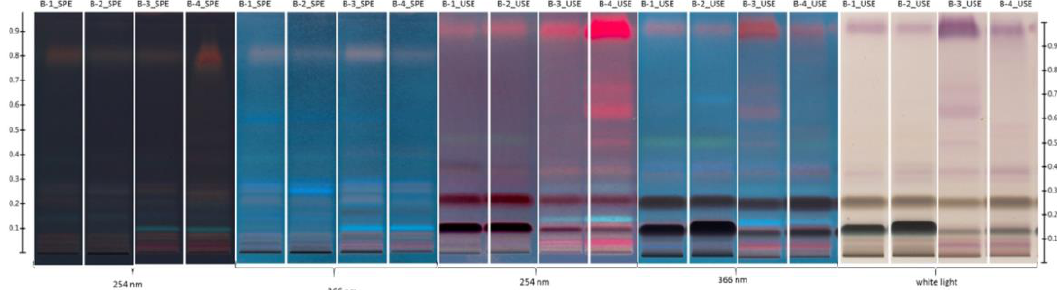
Figure 1. Represented HPTLC fingerprint of buckwheat honey after derivatisation (UAE—ultrasound solvent extraction, SPE—solid phase extraction visualised under white light, 254 nm and 366 nm; B1–B2 cv. Kora; B3–B4 cv. Panda; in Panda cv. we observed additional band on the chromatograms and, moreover, concentration of compound with Rf = 0.13 is less than in Kora cv.